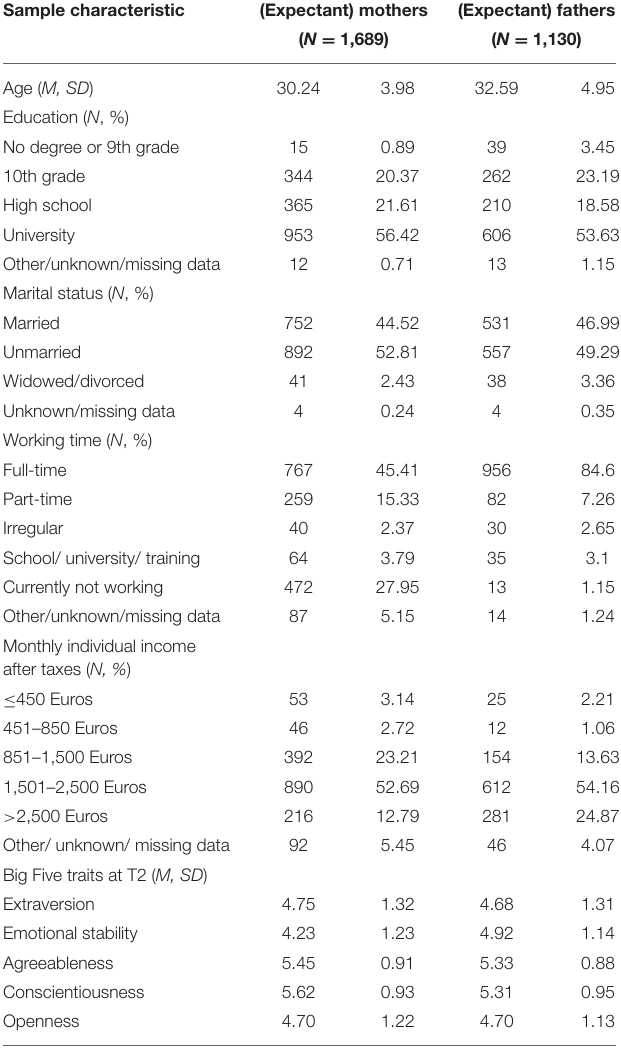
TABLE 3 | Baseline sample characteristics of the DREAM sample ( N = 2,819). Sample characteristic